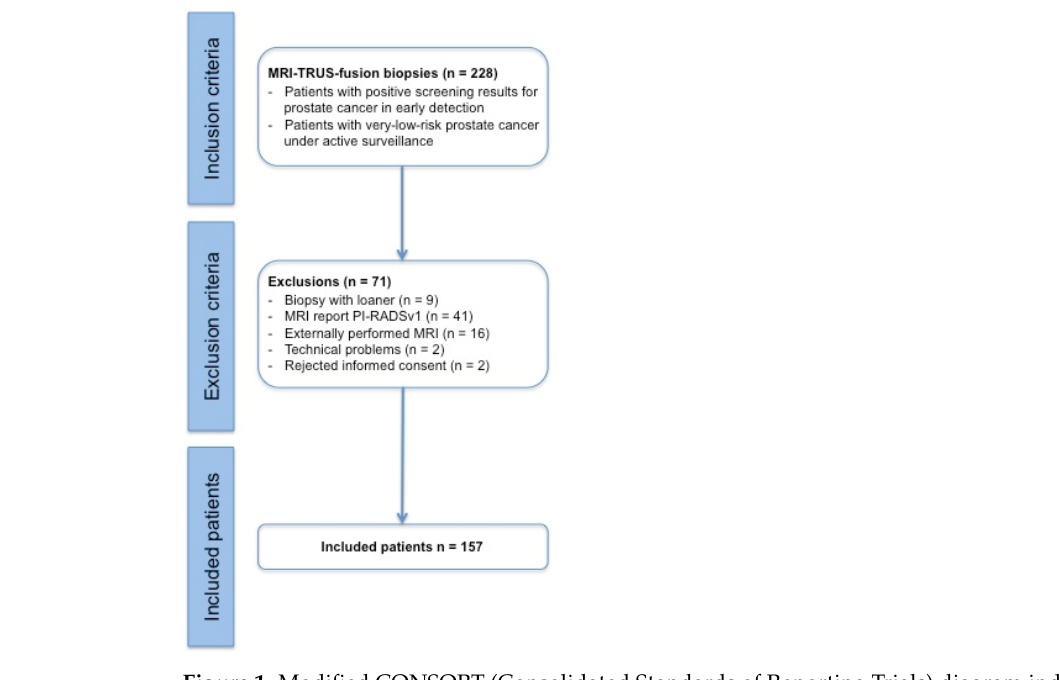
Figure 1. Modified CONSORT (Consolidated Standards of Reporting Trials) diagram indicating the number of participating patients and the reasons for study exclusions. Note: a “biopsy with loaner” is a biopsy with a replacement device and not with the device mentioned in Section 2.